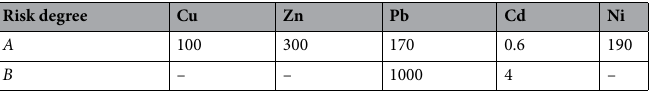
Table 1. Risk control standard value for soil contamination of agricultural land (mg kg −1 ).